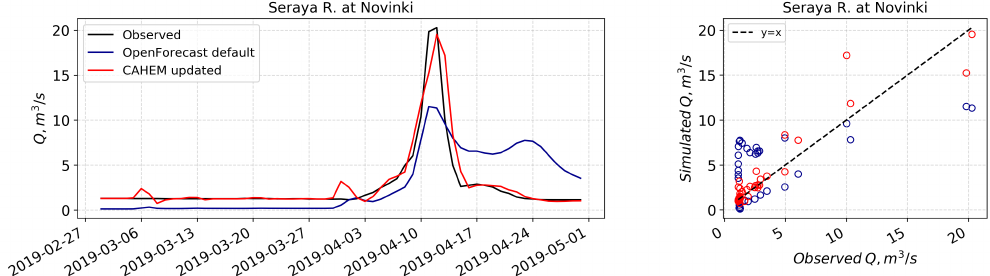
Figure 9. Results of parsimonious data assimilation technique proposed by CAHEM for operational runoff forecasting of the spring flood 2019 for Seraya R. at Novinki: hydrographs ( left plot ) and scatter plot ( right plot ) of observed and simulated discharges.